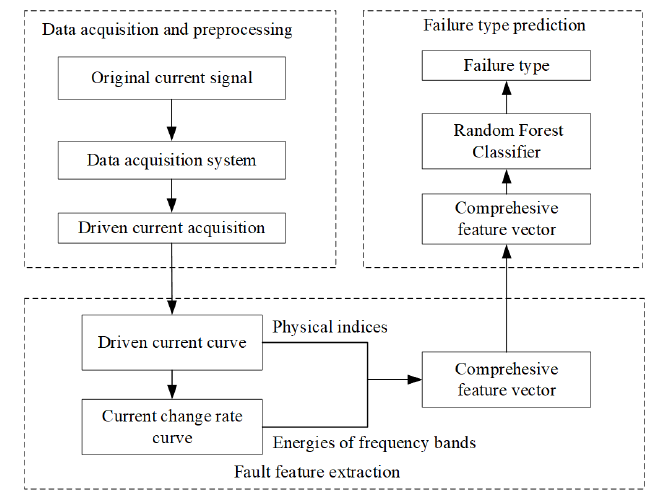
Figure 3. Scheme of proposed failure type prediction using physical indices and data